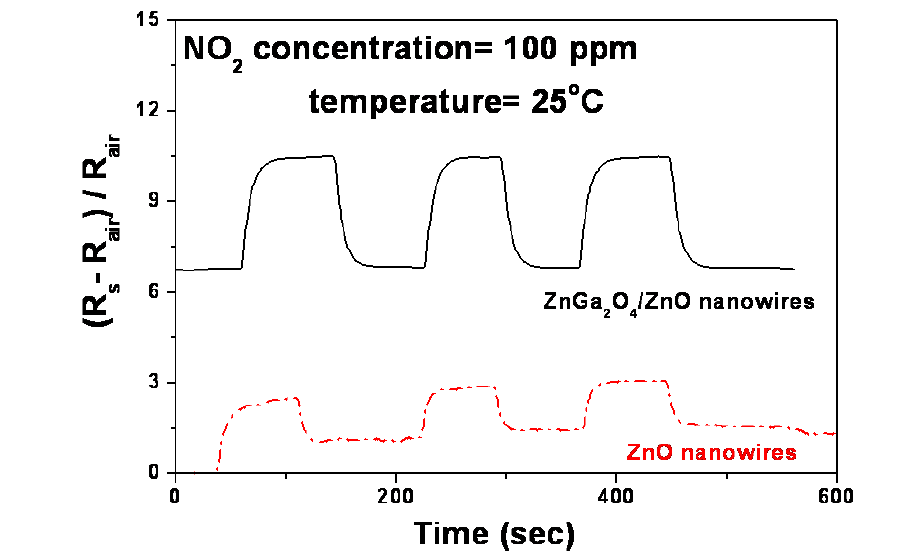
Figure 8. Repetitive response curves of ZnGa ZnO nanowire sensor at 25 °C, respectively. The testing gas is 100 ppm NO carrier gas.